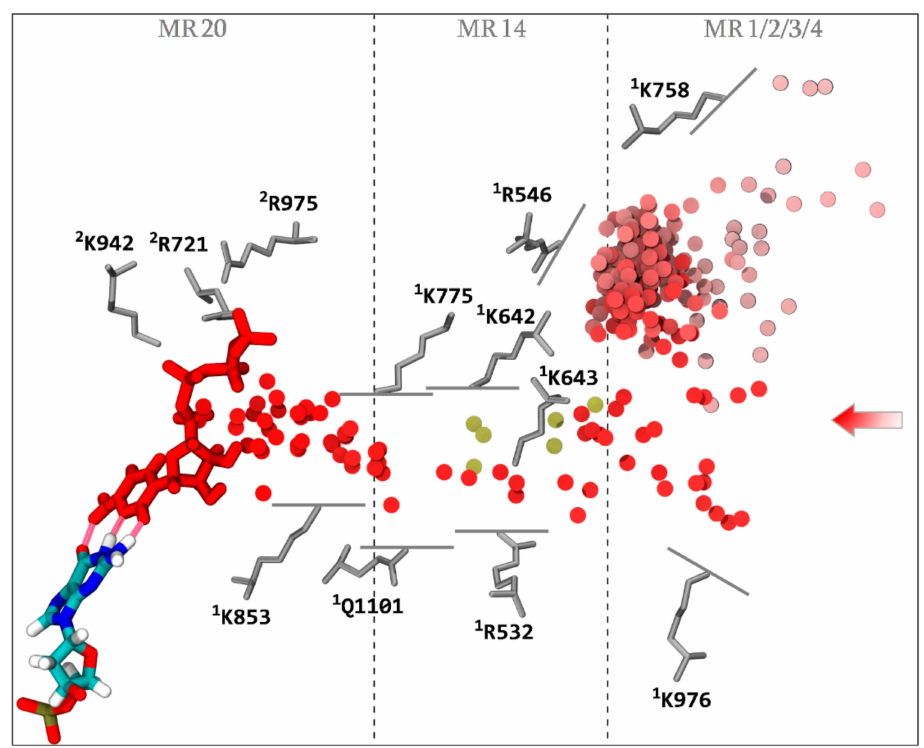
Figure 5. NTP loading through CH2. The successful di ff usion trajectory across CH2 consists of the consecutive simulations aMD_A5, aMD_K2 (restart of aMD_A5), and aMD_L2 (restart of aMD_K2). The incoming NTP initiates di ff usion into the funnel in aMD_A5 at 66.5 ns. The displayed trajectory is shown further along the funnel at the time point 102 ns. The center of mass of the NTP-MgB molecule, every 1 ns along the di ff usion trajectory, is shown as a series of discs, color coded from light red to red, chronologically. The NTP substrate (MgB not shown) at the end of the displayed trajectory (red), and the i + 1 dNMP DNA register (colored by atomic type), are represented as sticks. The hydrogen bonds completing the CH2 di ff usion process are represented as translucent red tubes. Key amino acids interacting with NTP-MgB are shown as grey sticks. Partial loadings along CH2 are represented as follows: most far-reaching alternative NTP di ff usion from aMD_A4 (33.5 ns), aMD_E5 (119 ns), aMD_F4 (187 ns), aMD_L5 (93 and 118.5 ns), and aMD_L6 (101 ns) are aligned into the main trajectory and the center of mass of the NTPs are represented as gold discs. Entry macro-regions MR1 to 4, and infiltrations regions MR14 and MR20, are